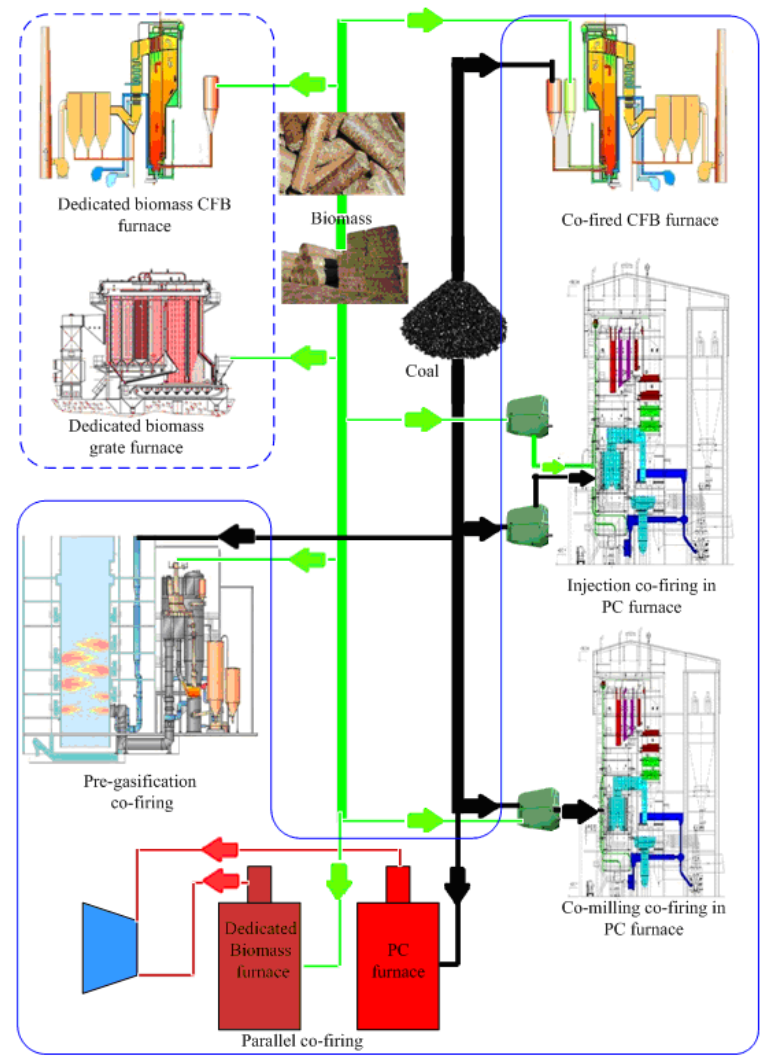
Figure 1. Illustration on biomass firing and co-firing